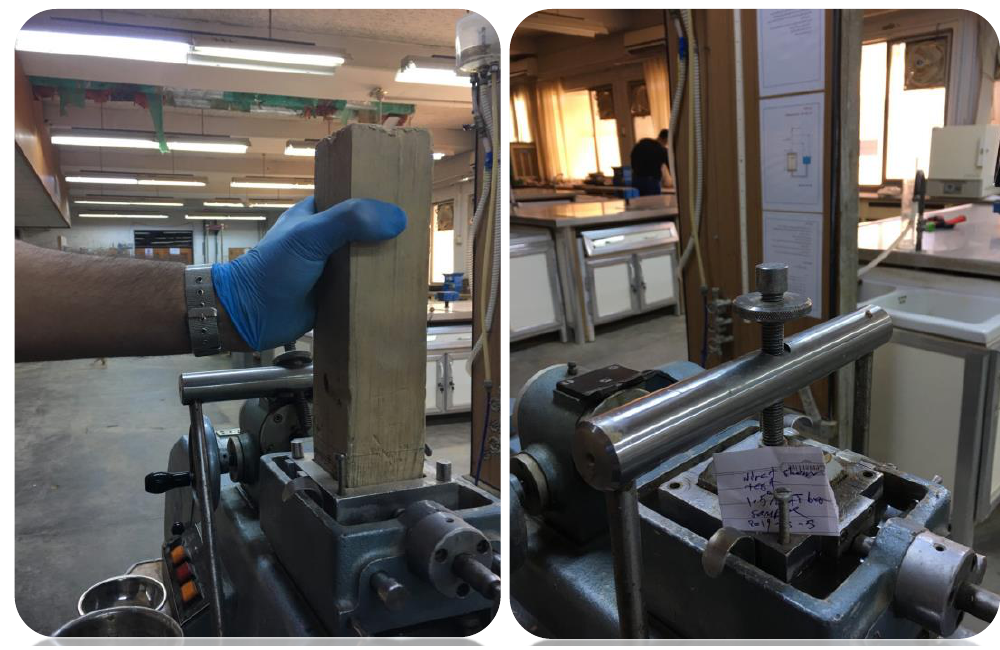
Fig. 3. Preparing soil specimens for direct shear test (tamping